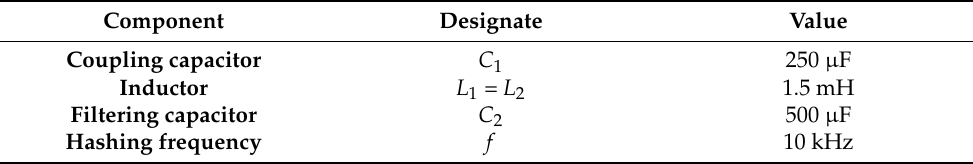
Table 3. SEPIC converter features.